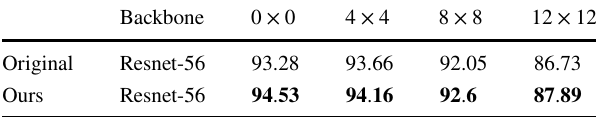
Fig. 8 The compared models are trained under the clean data ( 0 ◦ ) and directly evaluated on rotated images without model fintuning Table 3 Robustness against object occlusion in images is studied under three pixel drop